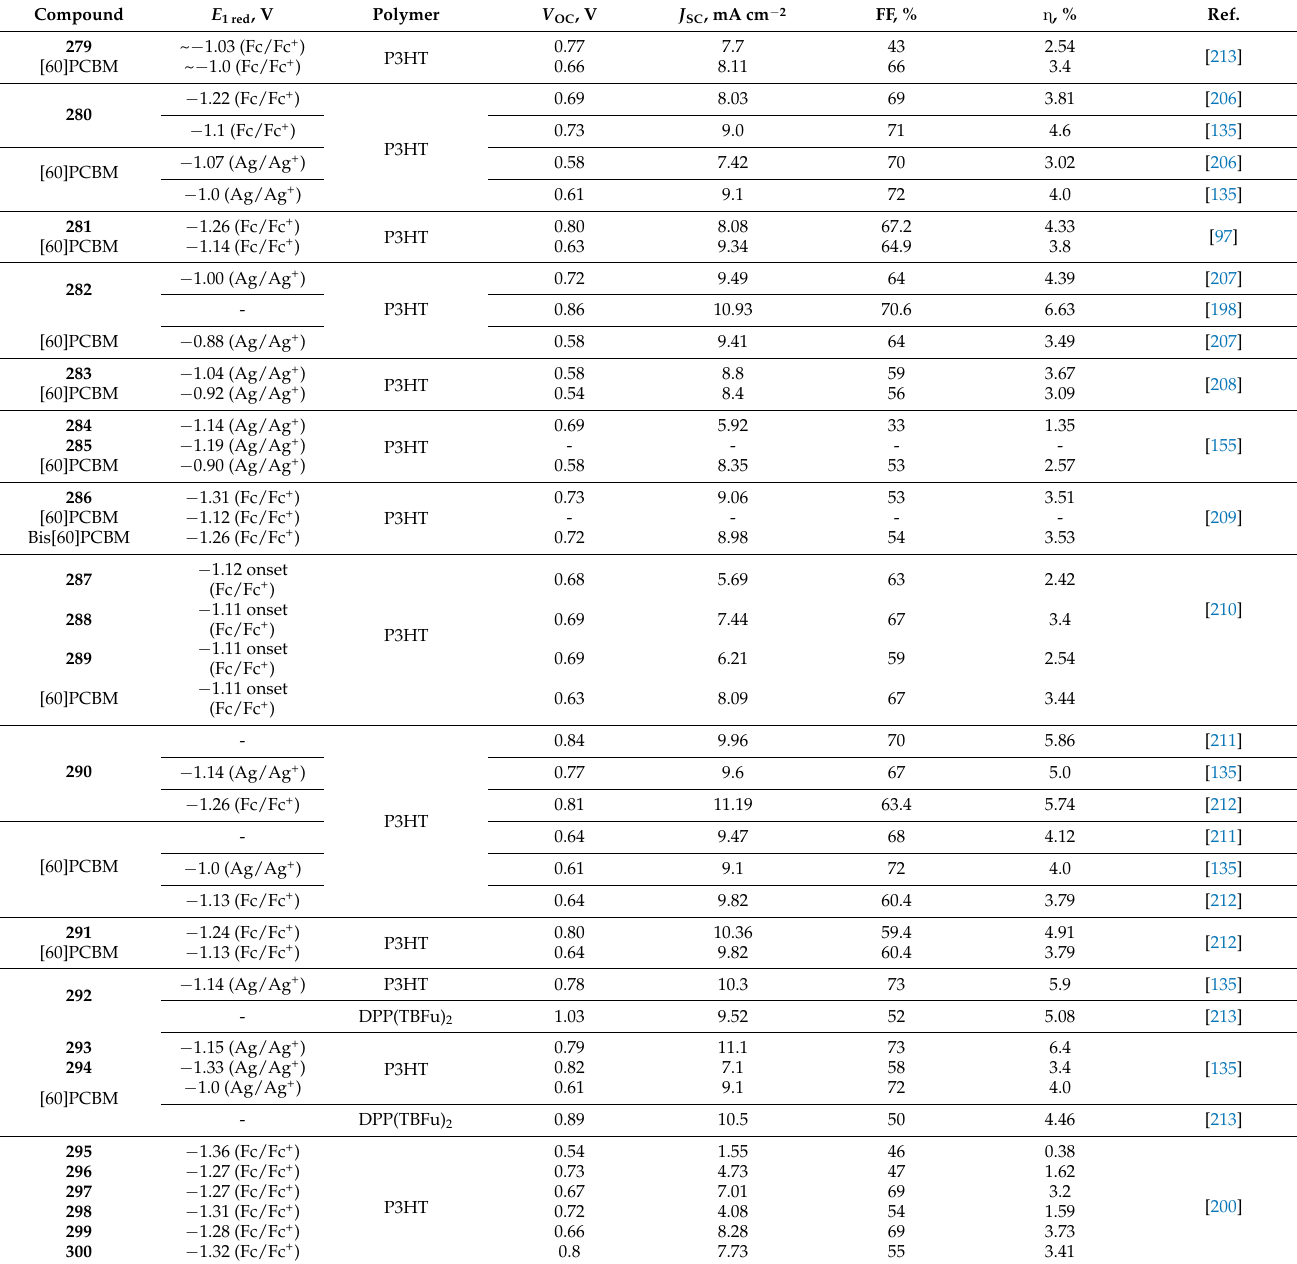
Table 10. First reduction potentials and characteristics of OSCs based on different types of bis(adducts) with reduced electron